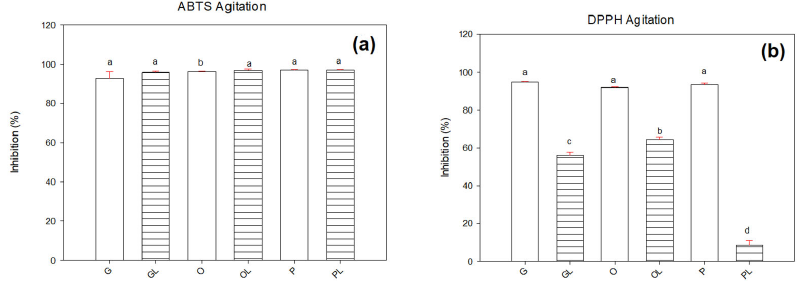
Figure 3. Inhibition of radicals in native oils and oils with lycopene by the agitation technique using ( a ) ABTS radical and ( b ) DPPH radical. Letters (a–c) represent significant differences between samples.